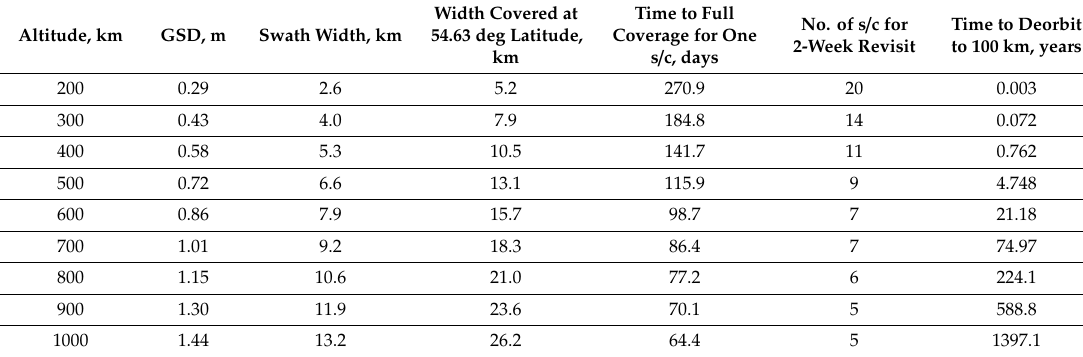
Table 3. Estimated GSD, swath width, revisit times, and deorbit time as a function of altitude for a spacecraft baselined against the SkySat